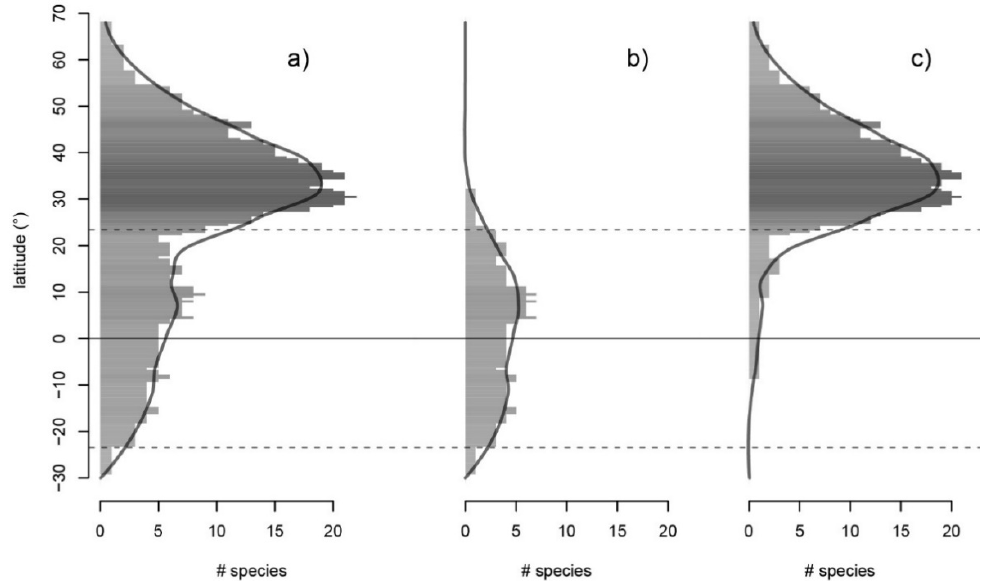
Figure 2. Latitudinal diversity gradient. Species richness by 0.5 ◦ latitudinal bin for ( a ) the complete Ulmaceae family, ( b ) the tropical clade and ( c ) the temperate clade. A smooth approximation is shown by the LOESS (locally estimated scatterplot smoothing) curve above the histogram. The equator is represented by the solid horizontal line, and the tropics are represented by the two dashed lines.